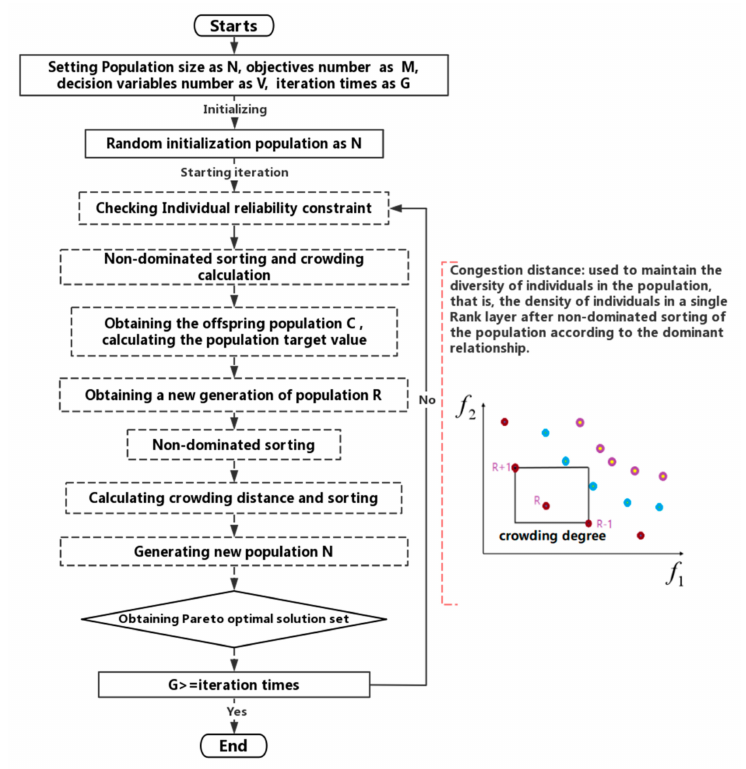
Figure 2. Calculation flowchart of